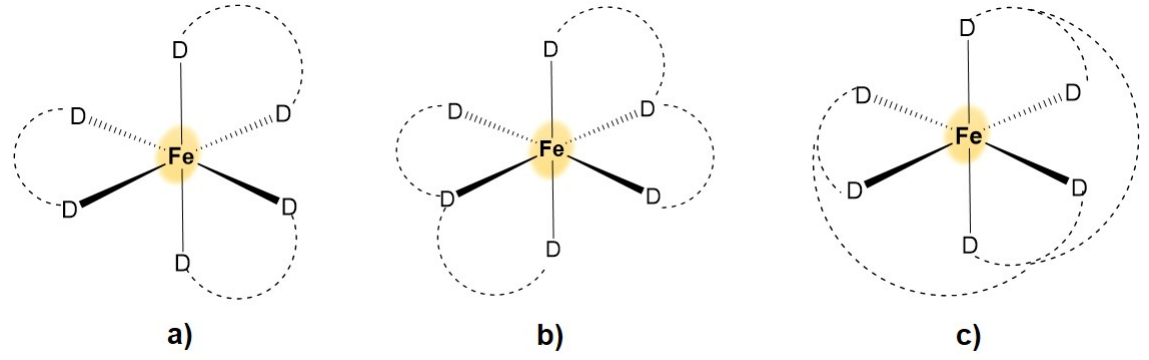
Figure 1. Octahedral complexation geometry of Fe(III) obtained with ligands of different denticities: ( a ) bi-, ( b ) tri- and ( c ) hexadentate ligands.